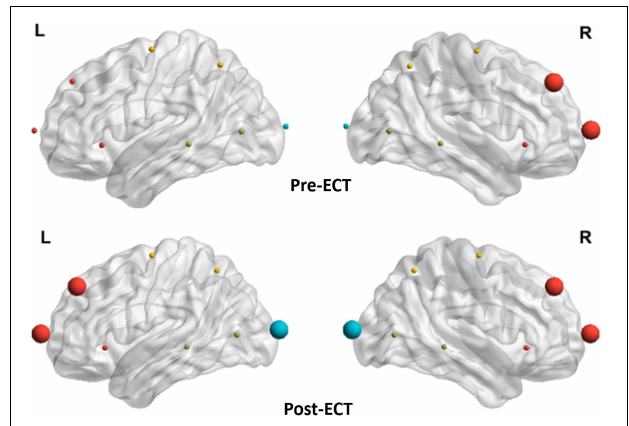
FIGURE 6 | Distribution of hubs of pre- and post-ECT patients with MDD in the alpha band. The enlarged spheres represent the network hubs. Red color nodes represent the frontal lobe; yellow color nodes represent the central lobe; green color nodes represent the temporal lobe; and blue color nodes represent the parietal-occipital lobe.